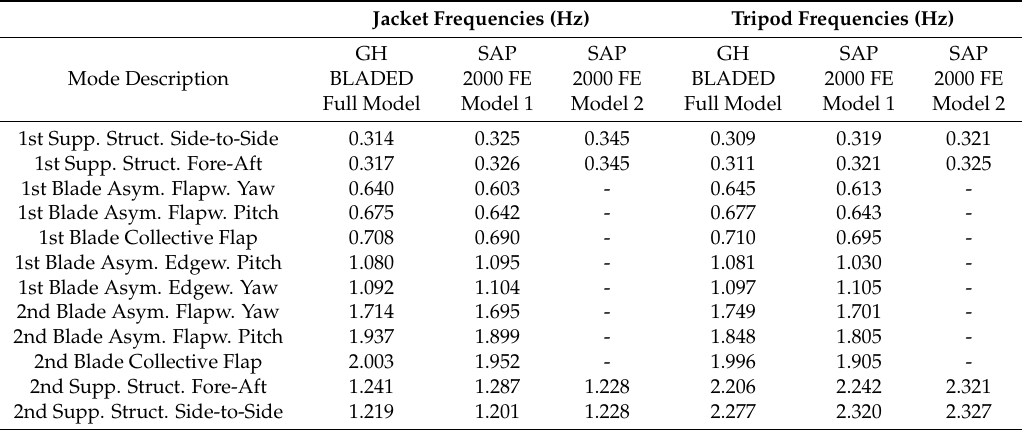
Table 1. Natural frequencies of Full Model in GH-BLADED and FE Models 1-2 in SAP